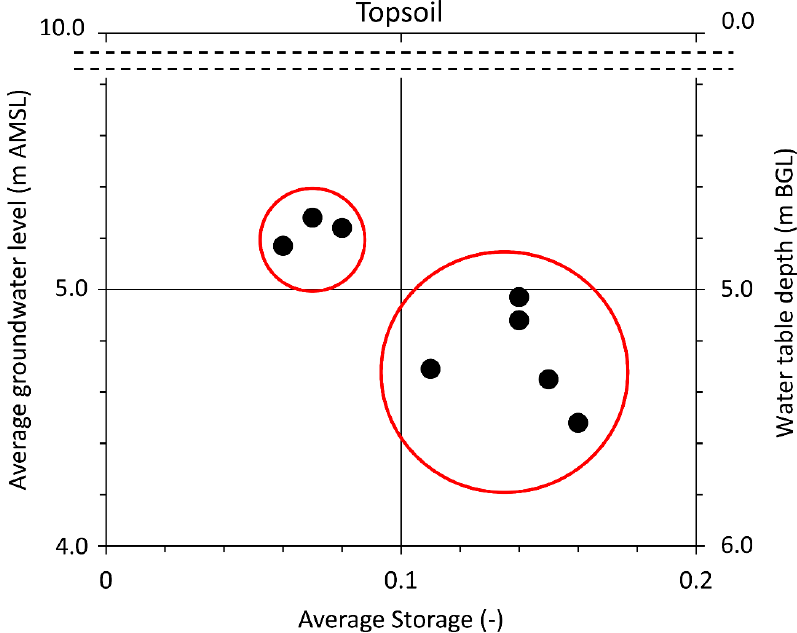
Figure 7. Relationship between the average groundwater level AMSL (m) (water table depth (m) BGL) and the average storage coefficient, as reported in Table 1. The storage coefficient decreases systematically when the average groundwater level is higher than ≈ 5 m AMSL.